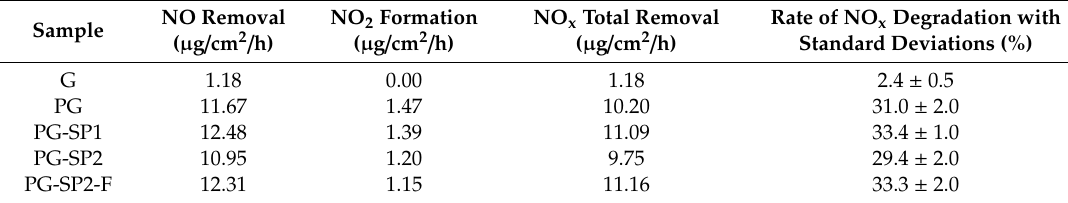
Table 4. Activity of modified gypsum plasters toward NO x